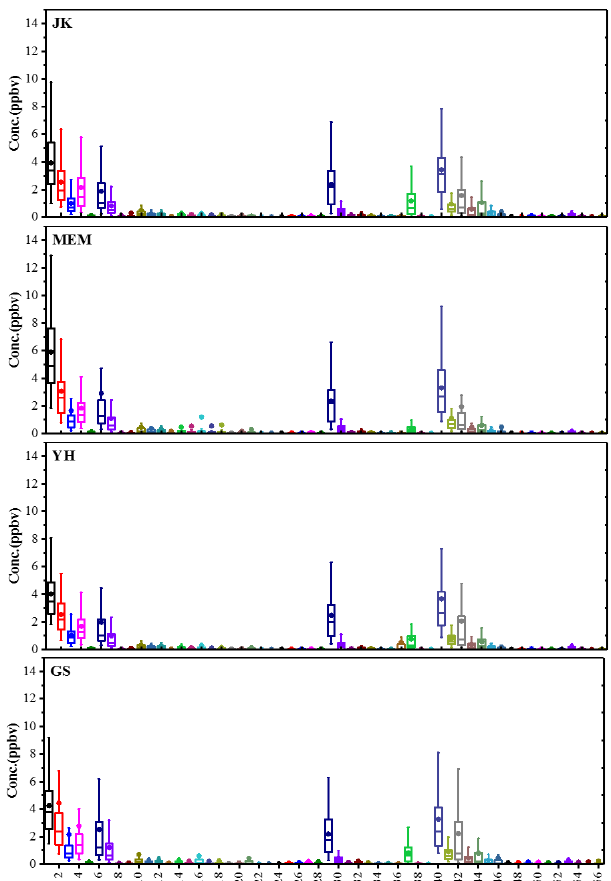
Figure 8. Concentrations of 57 VOCs at each site for the whole sampling period. The whiskers show the 5–95th percentiles, and the box shows the 25–75th percentiles. The solid points show the arithmetic average, and the line in the box shows the median. The chemicals are listed in Table S1.